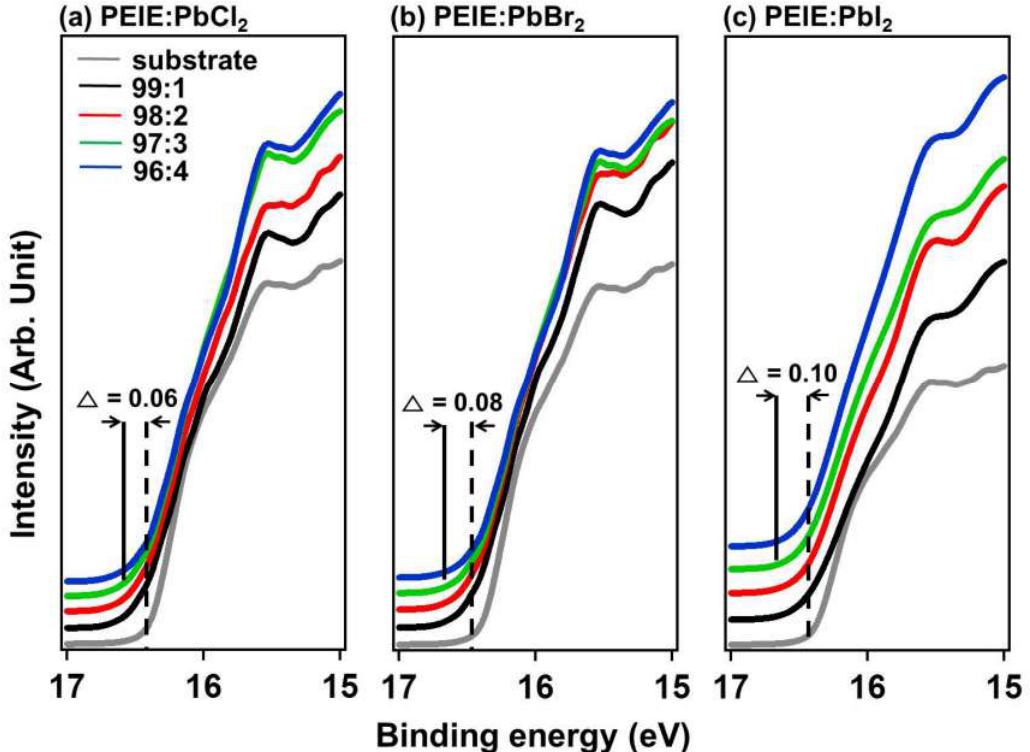
Figure 4. Secondary electron cutoff ultraviolet photoelectron spectroscopy (UPS) spectra for ( a ) PEIE:PbCl 2 , ( b ) PEIE:PbBr 2 , and ( c ) PEIE:PbI 2 films as a function of the organic and inorganic composite ratio.